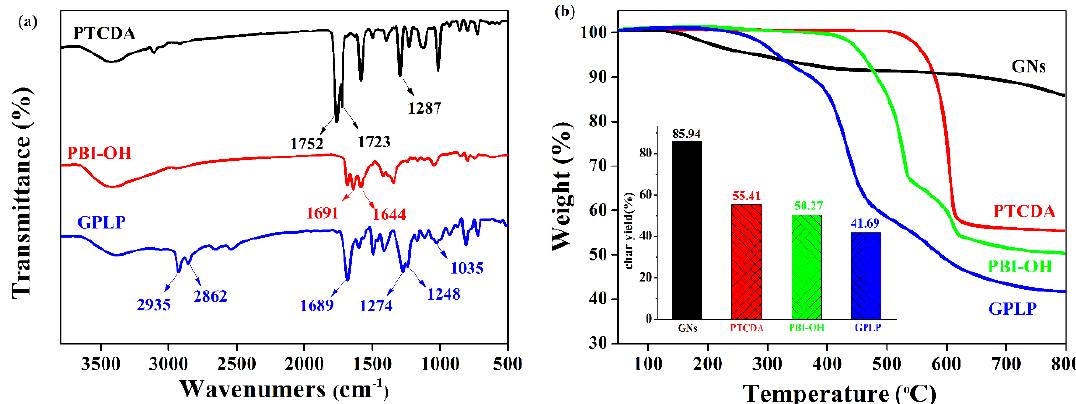
Figure 2. ( a ) FTIR spectra; and ( b ) Thermo-gravimetric analyzer (TGA) curves of graphene nanosheets (GNs), Perylene tetracarboxylic anhydride (PTCDA), PBI-OH and GPLP.